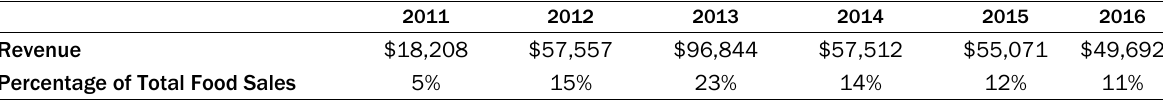
Table 4. Revenue from the Market Café, 2011 – 2016